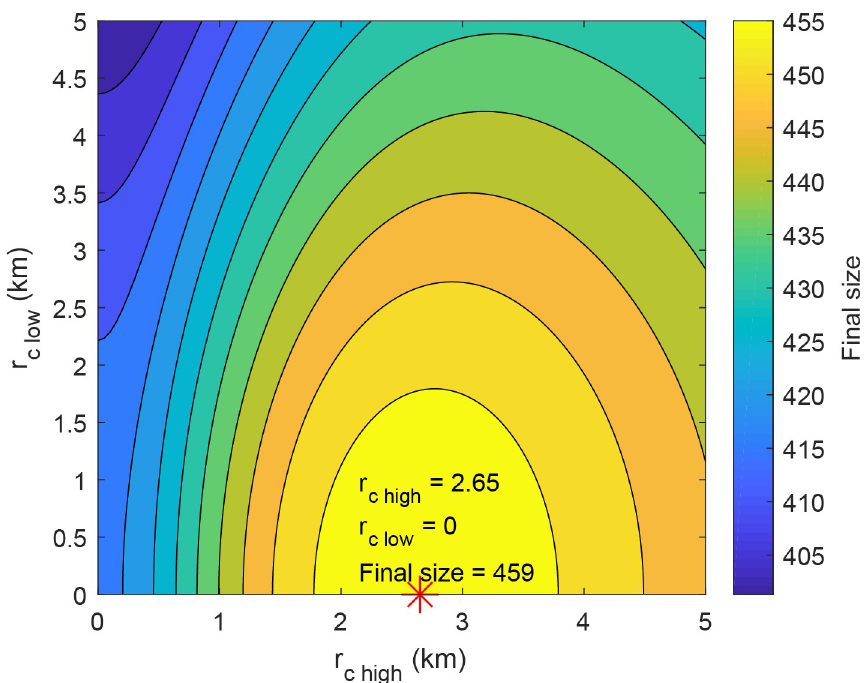
Fig 6. Impact of local-dependent culling radii on the final size of susceptible farms. The final size of susceptible farms with respect to culling radii is maximized as 459 when r